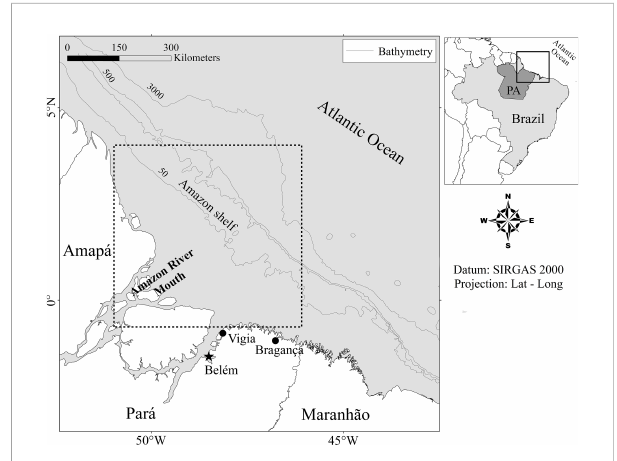
FIGURE 1 Study area on the Amazon Shelf and the principal fi shing ports in the northern Brazilian state of Para ́ at which the acoupa weak fi sh ( Cynoscion acoupa ) gillnet fi sheries landed their shark bycatch. The major ports of Vigia, Braganc ̧ a, and Bele ́ m are also identi fi